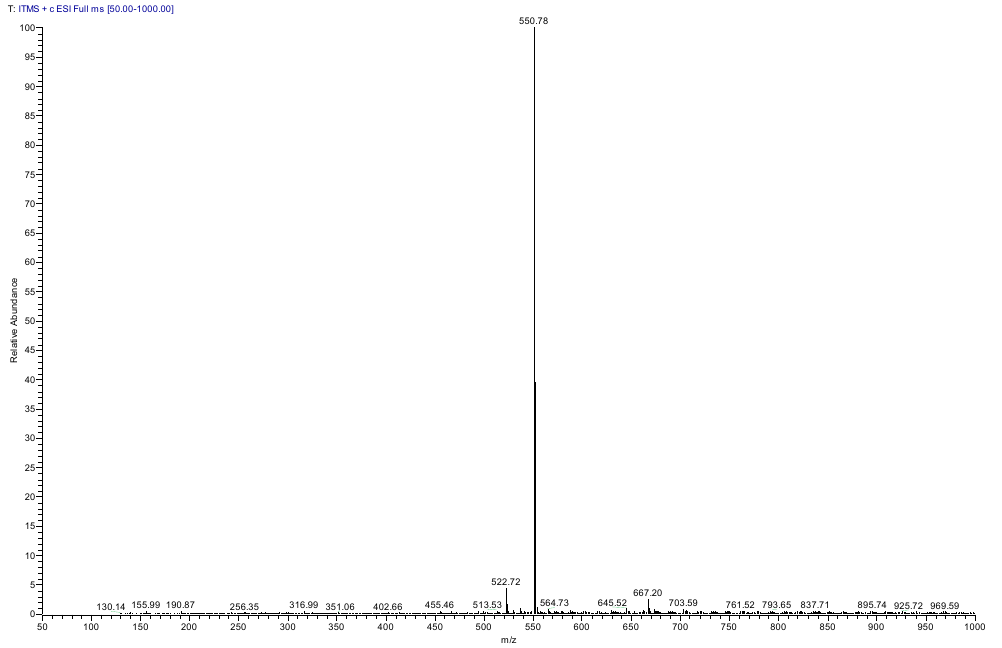
Figure 2. Absorption spectrum of red beetroot lyophilized extract in aqueous solution (at a concentration of 1.73 × 10 − 3 g/mL). Inset: Spectral decomposition in the visible region to obtain betacyanins and betaxanthins content.